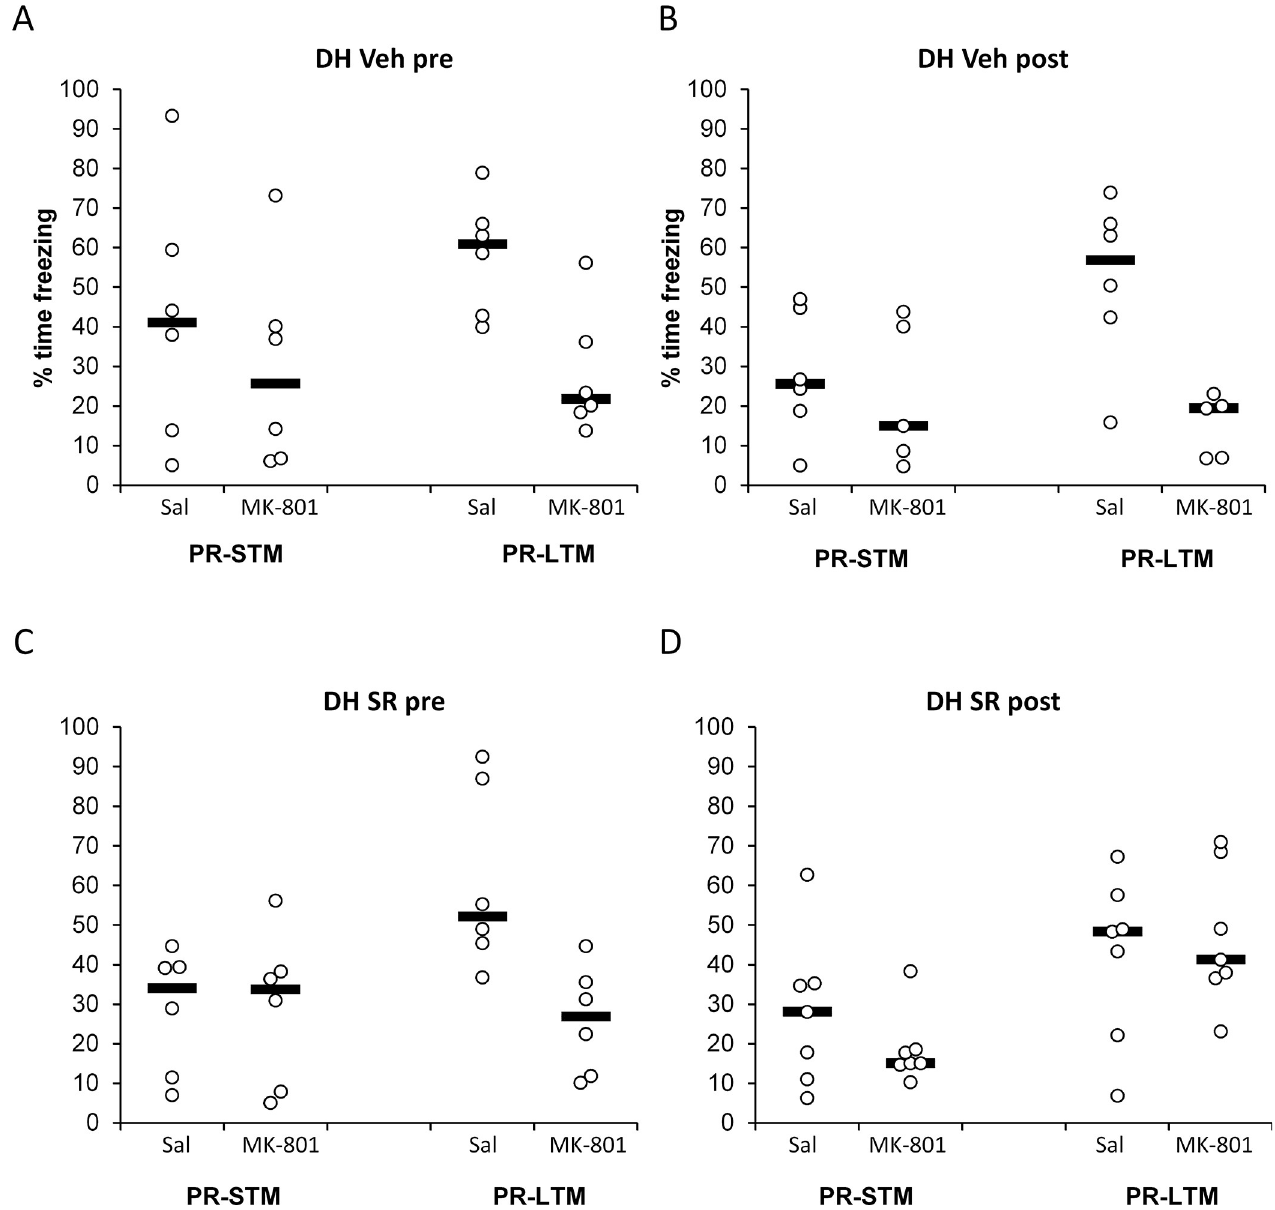
Fig 1. SR141716A infusion into the dorsal hippocampus blocked the amnestic effect of MK-801 when SR141716A was infused immediately after, but not before memory reactivation. MK-801 injection (0.1 mg/ml, i.p.) impaired freezing in the post-reactivation long-term memory test (PR-LTM) in rats infused with vehicle prior to (A) or immediately after (B) memory reactivation. While pre-reactivation infusion of SR141716A (8 μ g/ μ l) did not alter the amnestic effect of MK-801 (C), post-reactivation SR141716A prevented the MK-801-induced impairment in freezing at PR-LTM (D). Statistical analyses confirmed a selective effect in the post-reactivation SR141716A condition (Timing x Infusion x Injection: F(1,41) = 5.19, p = 0.028, η 2 p = 0.11). No effect of MK-801 injection or SR141716A infusion was observed in the post-reactivation short-term memory test (PR-STM). Data are presented as individual units and mean. n = 6 for all pre-reactivation groups, 6 for post-reactivation Saline, 5 for post-reactivation MK-801 and 7 for post-reactivation SR141716 + Saline and SR141716 + MK-801.